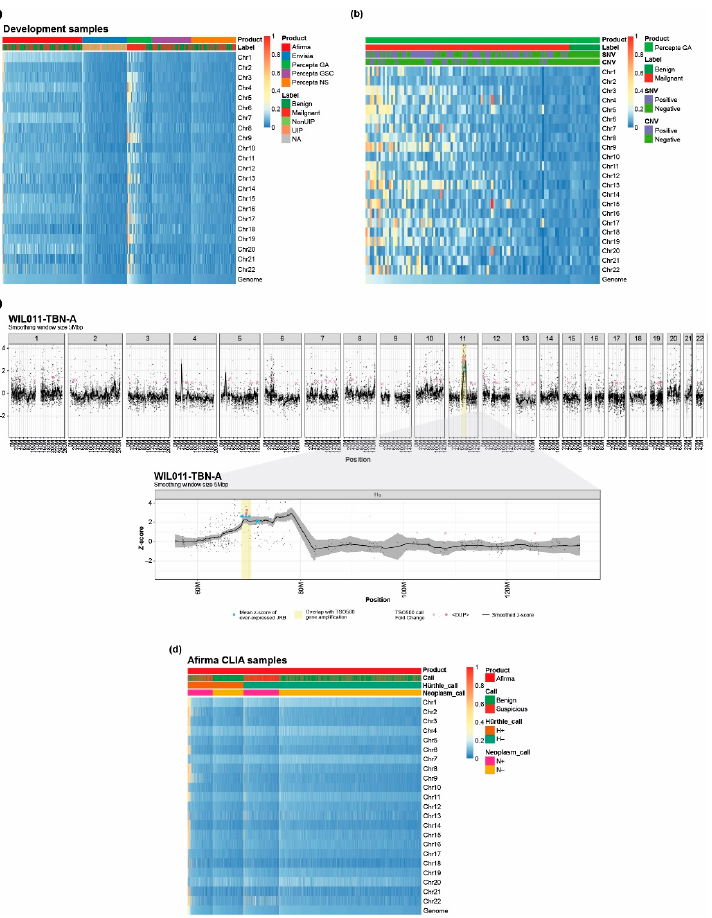
Figure 4. Chromosome and genome-wide LOH across diseases and tissues. ( a ) Chromosome and genome-wide LOH across lung (Percepta), thyroid (Afirma), and ILD (Envisia) samples; ( b ) chromosome and genome-wide LOH across specific lung cancer specimens; ( c ) comparison of results using TSO500 and expression-based CNV identification in an NSCLC-adenocarcinoma sample. The center of the highlighted region on chromosome 11 is gene CCND1, for which a duplication was identified by both TSO500 and expression-based CNV identification; ( d ) chromosome and genome-wide LOH across specific thyroid cancer specimens. Numbers next to the color bar represent the color scale of